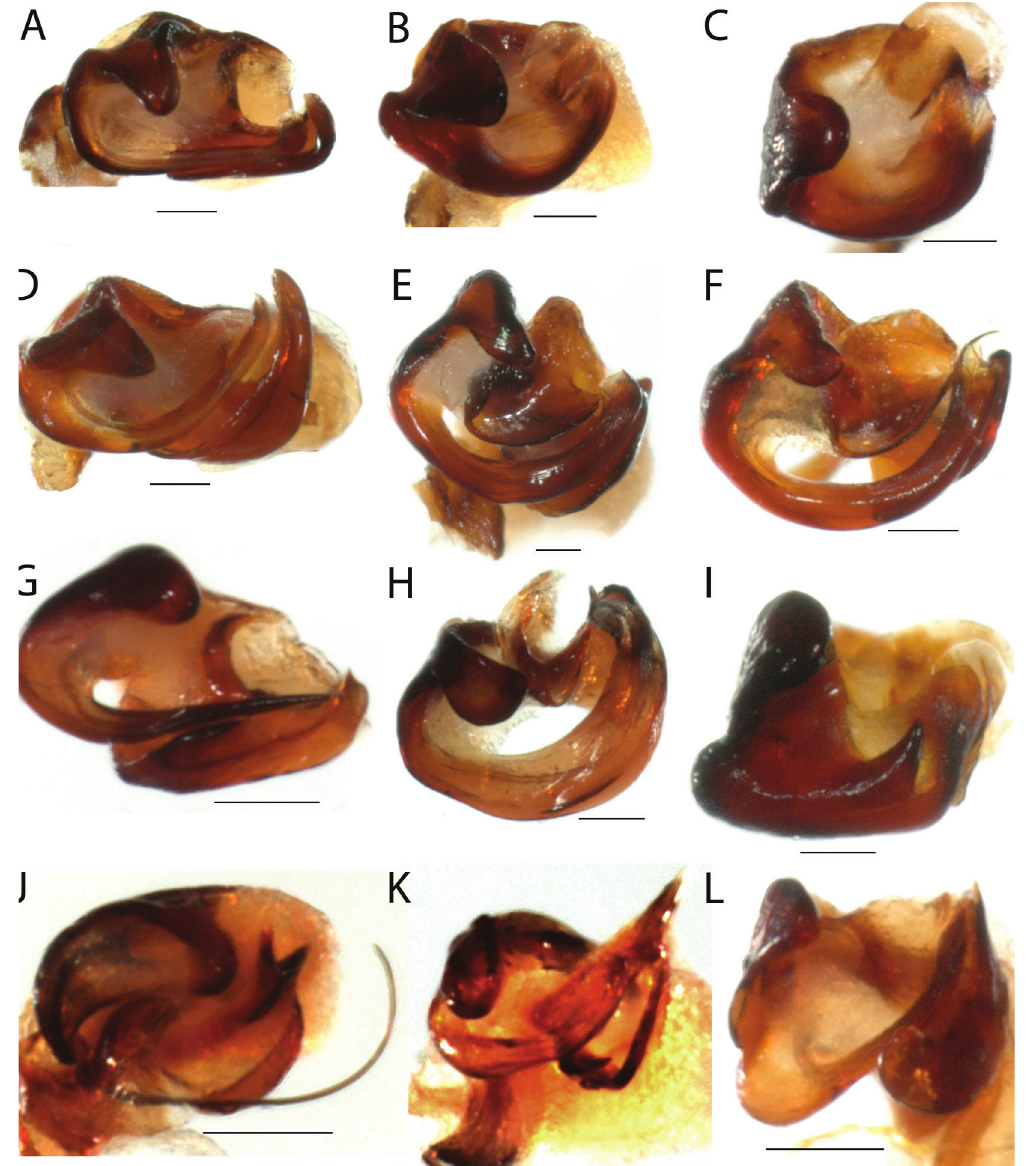
Figure 46. Artoria spp., palea of male pedipalp, ventral view: A , A. lineata (L. Koch, 1877) (AM KS21673); B , A. ulrichi Framenau, 2002 (AM KS4316); C , A. quadrata Framenau, 2002 (AM KS61739); D , A. flavimana Simon, 1909 (AM KS52091); E, A. gloriosa (Rainbow, 1920) (AM KS84008); F , A. albopilata (Urquhart, 1893) (AM KS116121); G , A. mckayi Framenau, 2002 (AM KS45830); H , A. berenice (L. Koch, 1877) (AM KS75080) I , A. victoriensis Framenau, Gotch & Austin, 2006 (AM KS843630); J , A. howquaensis Framenau, 2002 (AM KS82788); K , A. triangularis Framenau, 2002 (AM KS99035); L , A. alta Framenau, 2004 (AM KS45825). Scale bars: 0.1